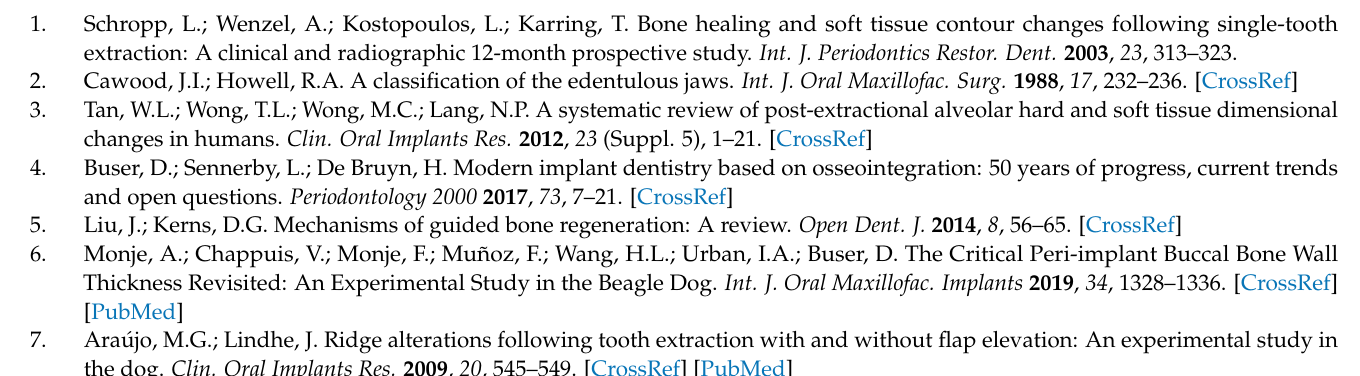
Table S2: Cochrane Risk of bias of clinical trials; Table S3: Joanna Briggs Risk of bias of case